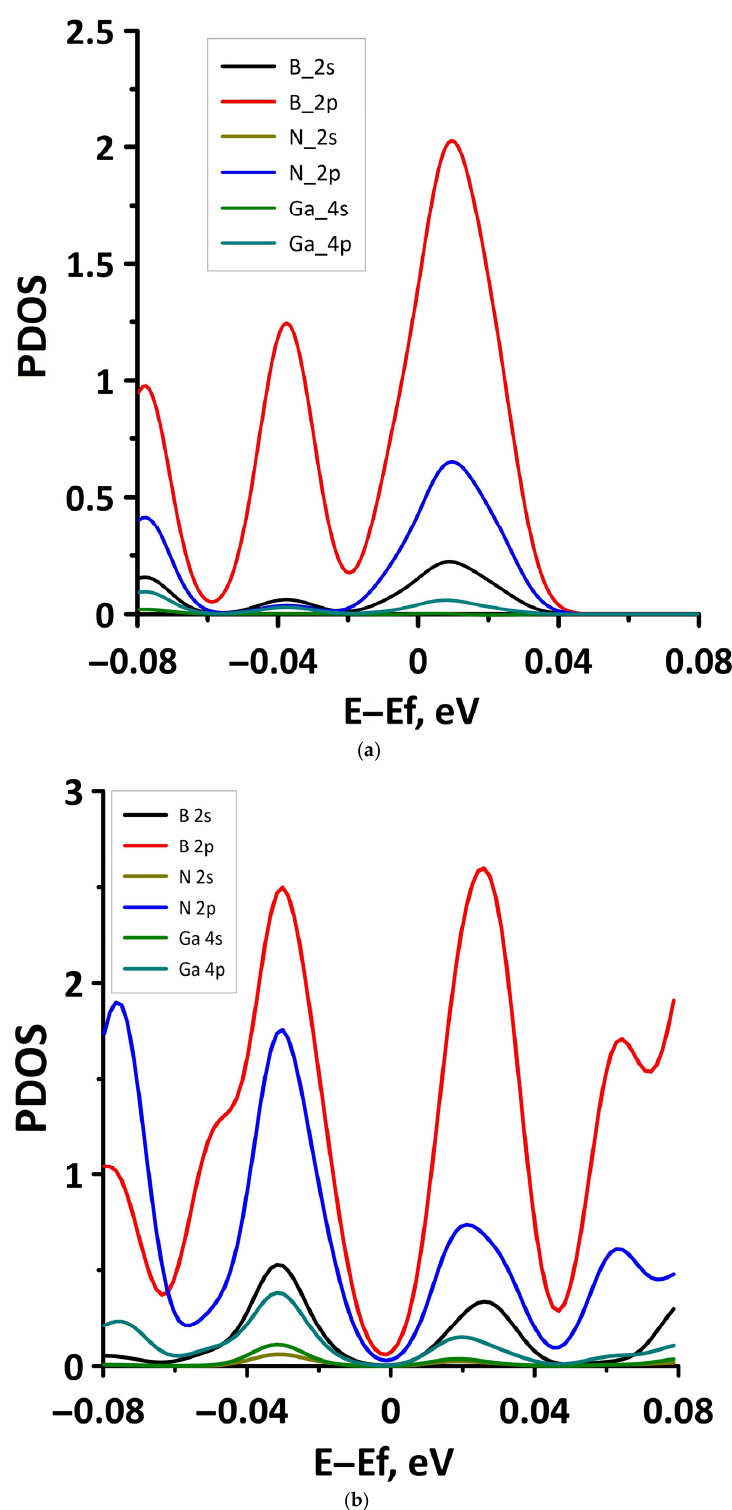
Figure 9. Fragments of the band diagrams near the Fermi level (shifted to 0 eV) of borophene/GaN heterostructure under uniaxial stretching by 1% ( a ) and 14% ( b ). The VBM is highlighted in red and the CBM is highlighted in blue.